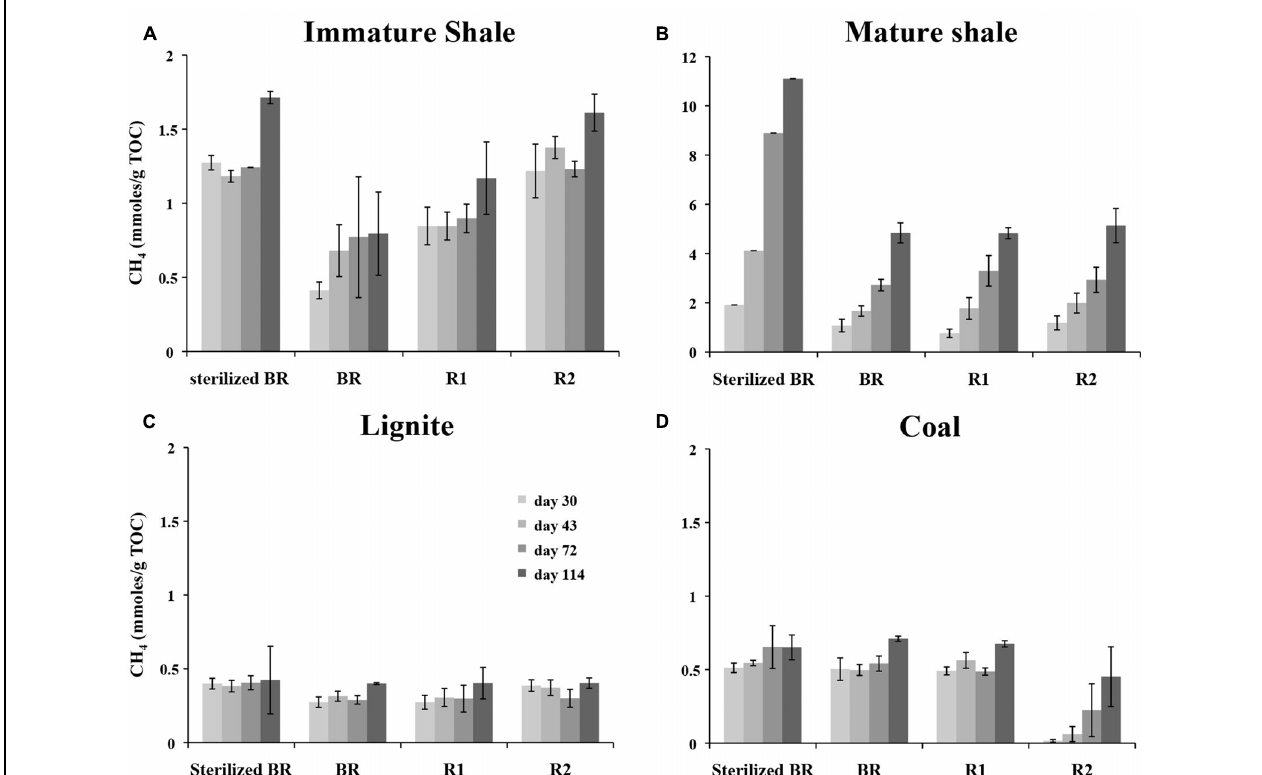
FIGURE 2 | Methane accumulation in the microcosms containing the different substrates prepared from the four sedimentary rocks sampled. (A) Immature Shale; (B) Mature Shale; (C) Lignite; (D) Coal. The SD was calculated based on GC-FID measurements on triplicate